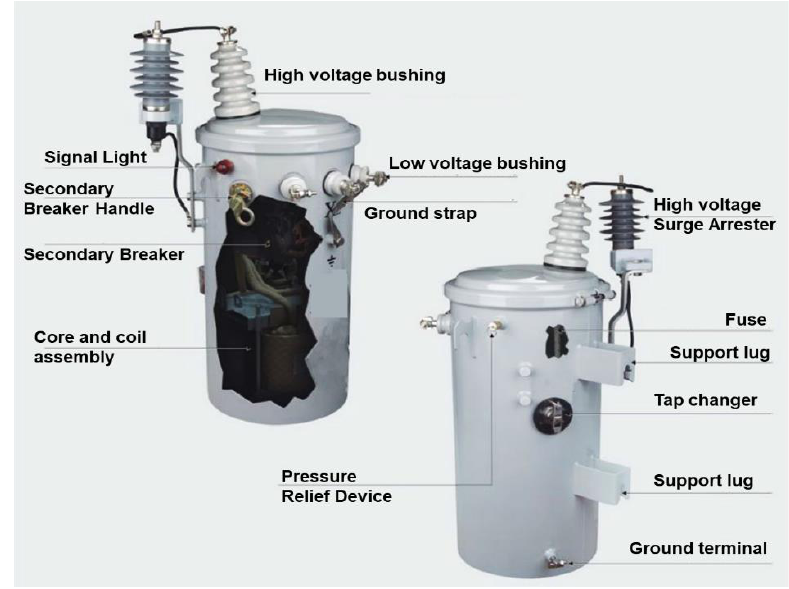
Figure 1. Structure of a distribution transformer.